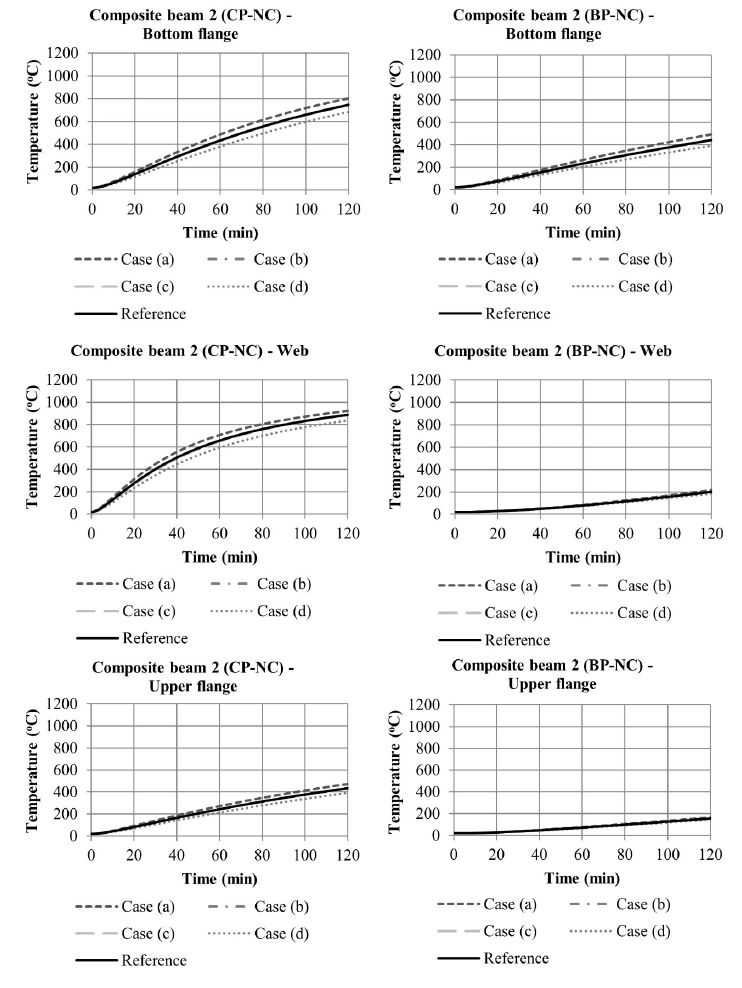
Figure 15. “Temperature x time” curves of reference metallic profile and of the situations analyzed with contour and box-type fire protection